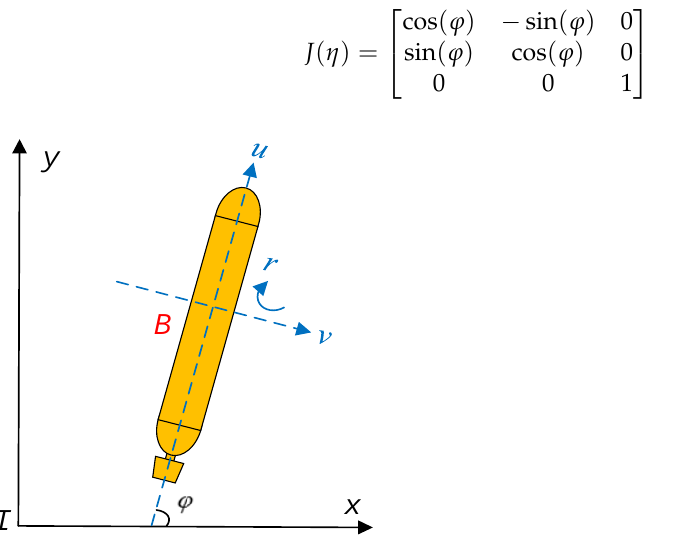
Figure 3. Inertial Coordinate System and Body Coordinate System.